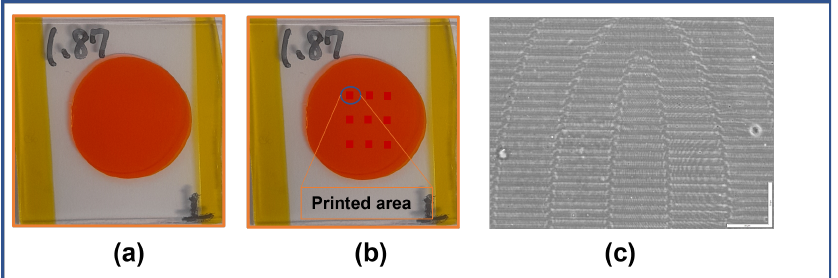
Figure 6. ( a ) Photograph of the synthesized azocarbazole polymer film sample. ( b ) Photograph of the sample with 9 holograms printed on film. ( c ) Phase contrast image of the printed hologram (scalebar is 50 µ m in